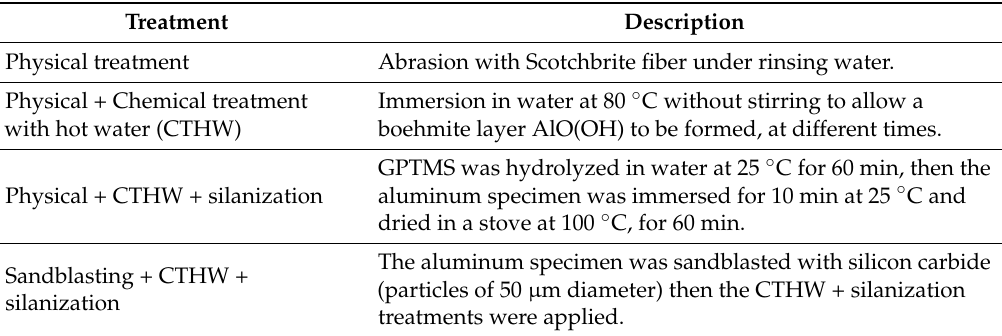
Table 7. Surface pretreatment for aluminum specimens.